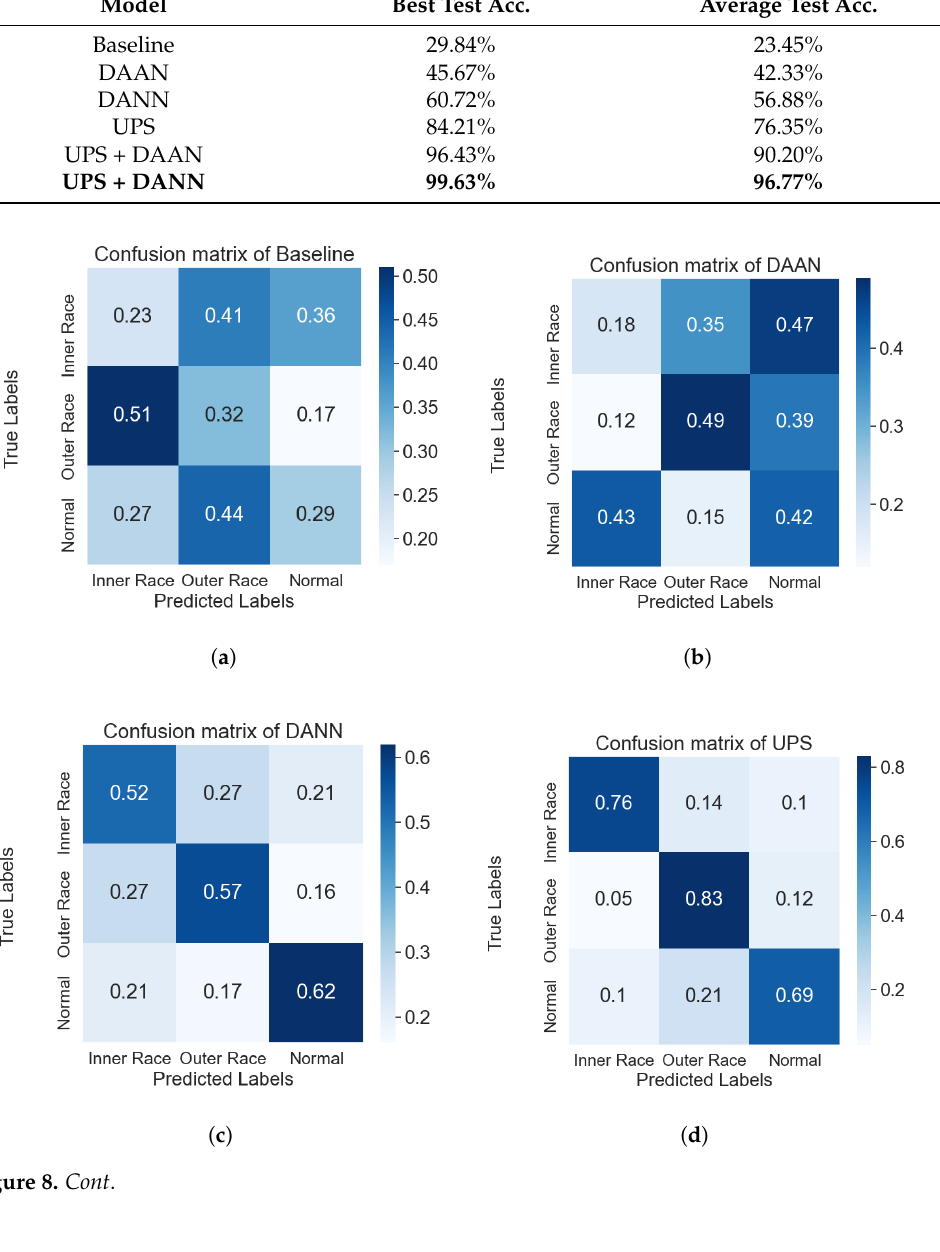
Table 5. Test accuracy comparison.